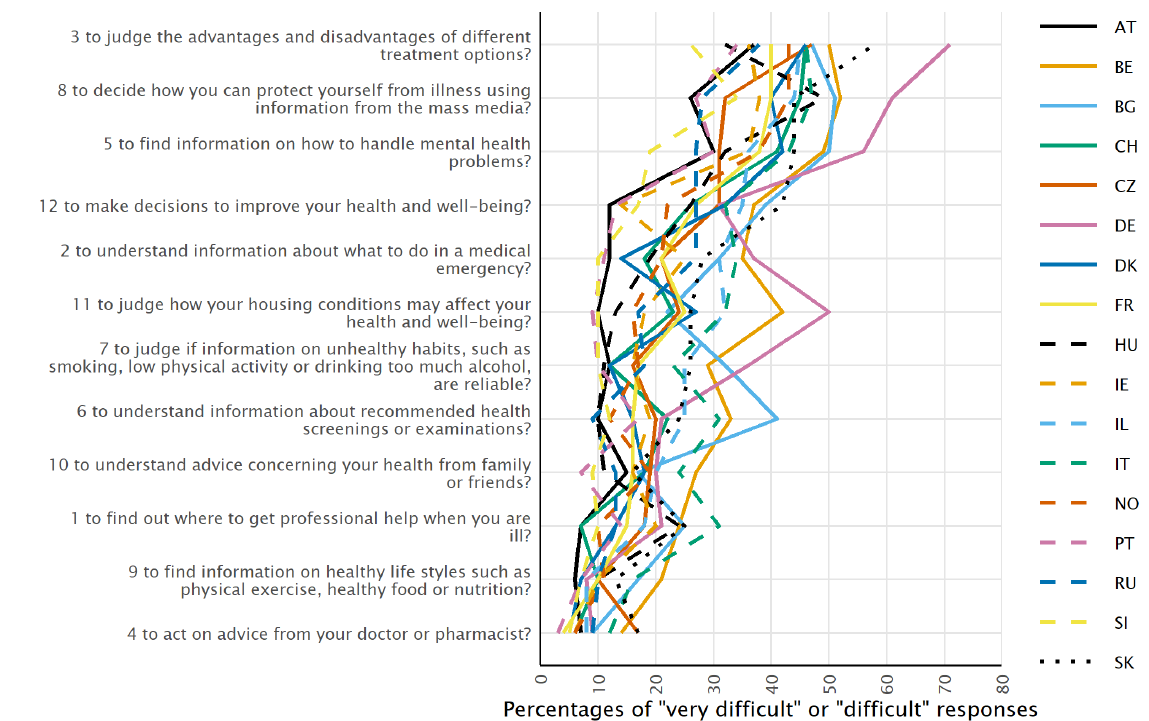
Figure 1. Percentages of respondents who responded with “very difficult” or “difficult” to the HLS 19 -Q12 items (ordered by the overall mean), for each country.